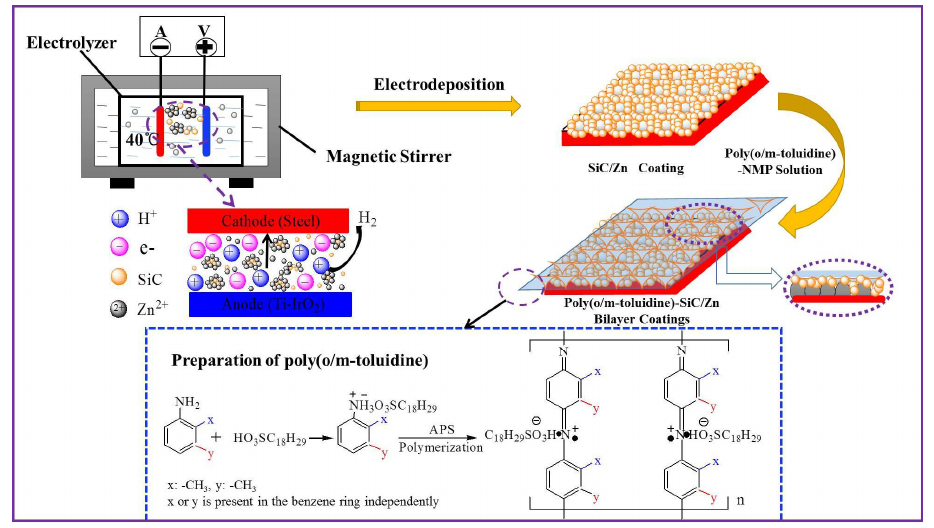
Figure 1. The schematic diagram fabrication of poly(o/m-toluidine)-SiC/Zn bilayer coatings.